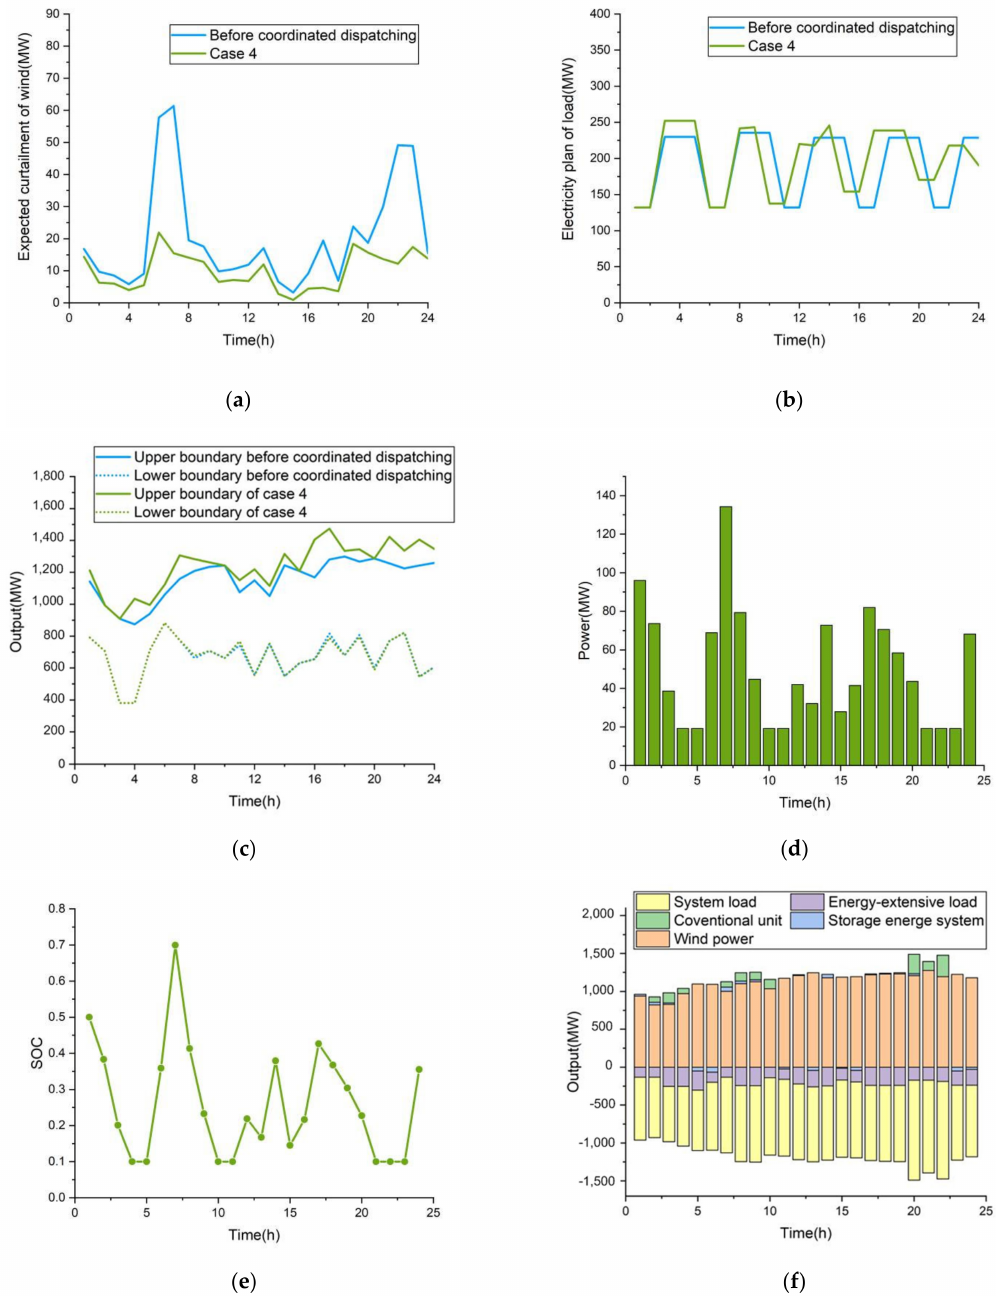
( a ) Curves of expected curtailment of wind; ( b ) Curves of electricity plan of load; ( c ) ARWP boundary of power grid; ( d ) Charging and discharging of energy storage system; ( e ) Energy storage system SOC; ( f ) System coordination dispatching